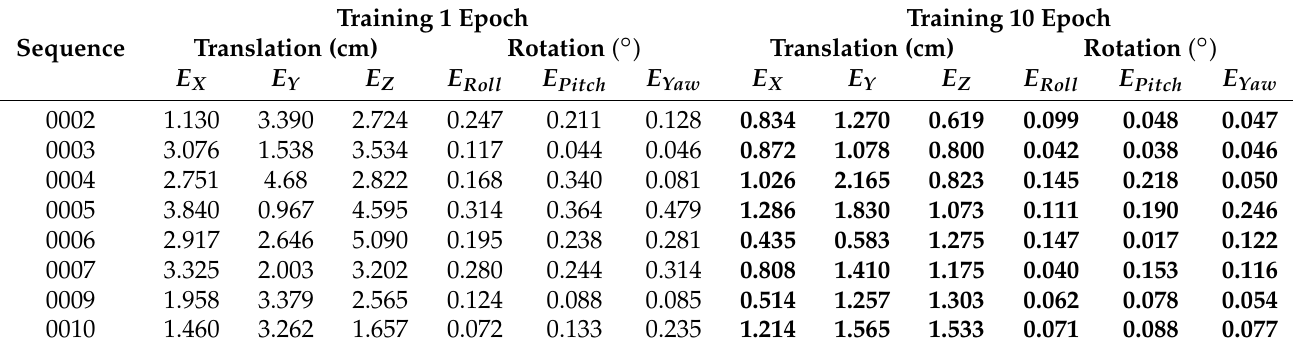
Table 5. The comparison of the calibration errors on KITTI360 datasets with different training epochs.